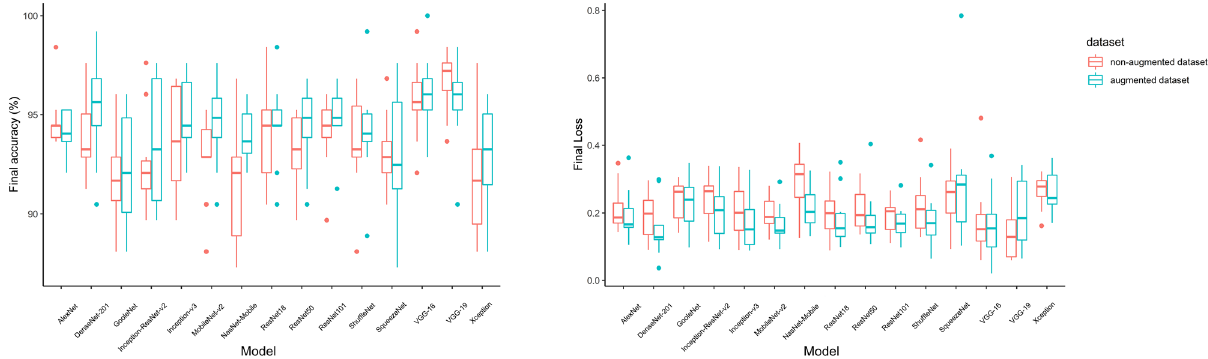
Figure 4. Training results for 10 folds of each deep learning